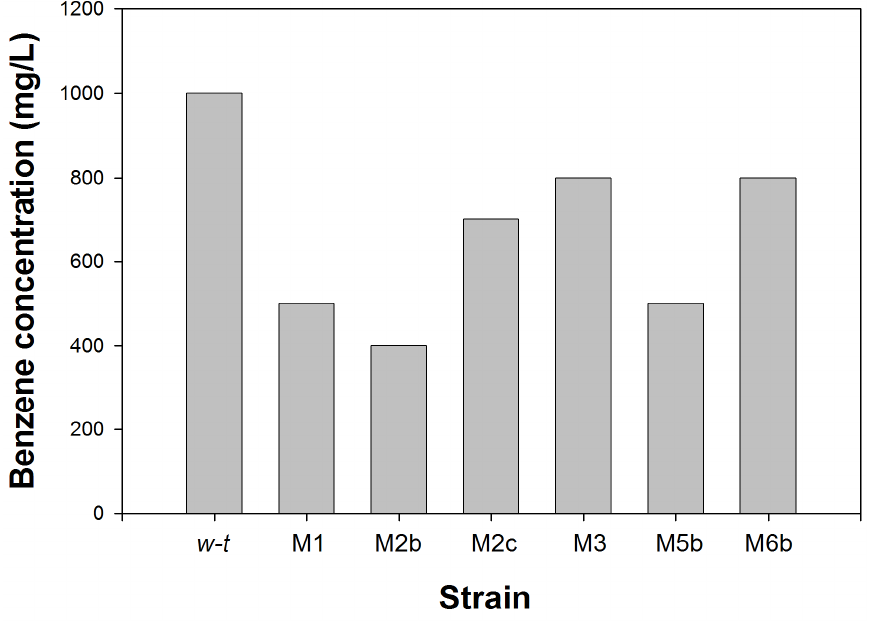
FIGURE 1. Tolerance limits of the w-t and its benzene-sensitive mutants to